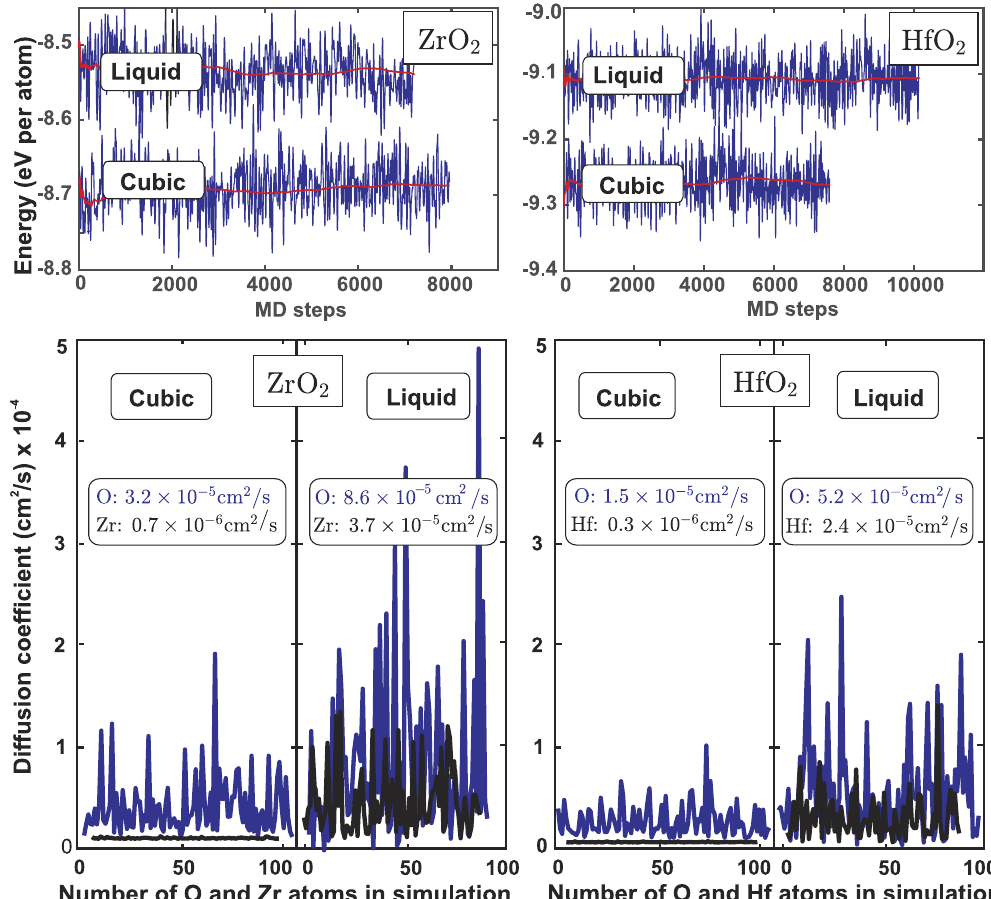
Figure 1. Top: Energy per atom in MD simulations for ZrO 2 and HfO 2 in solid cubic fluorite phase at 2727 °C and in liquid state at 2827 °C. Bottom: diffusion coefficients for O, Zr and Hf atoms in cubic and liquid phases obtained from the last 12 ps for the cubic and 29 ps for the liquid MD